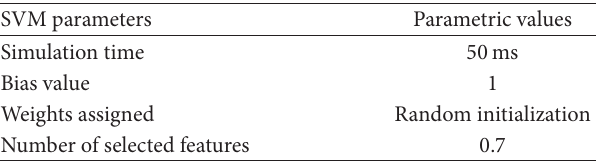
Table 3: Parameters of SVM